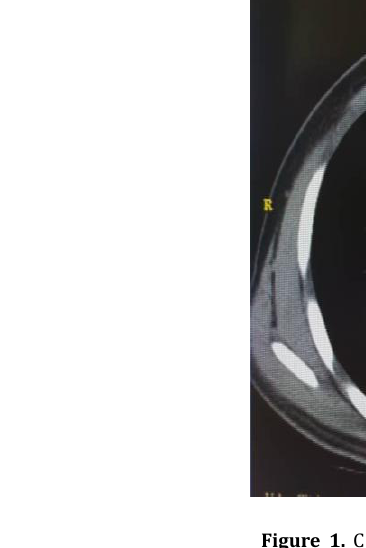
Figure 1. Computed tomography (CT) with a sharp chicken bone retrieved from the esophageal